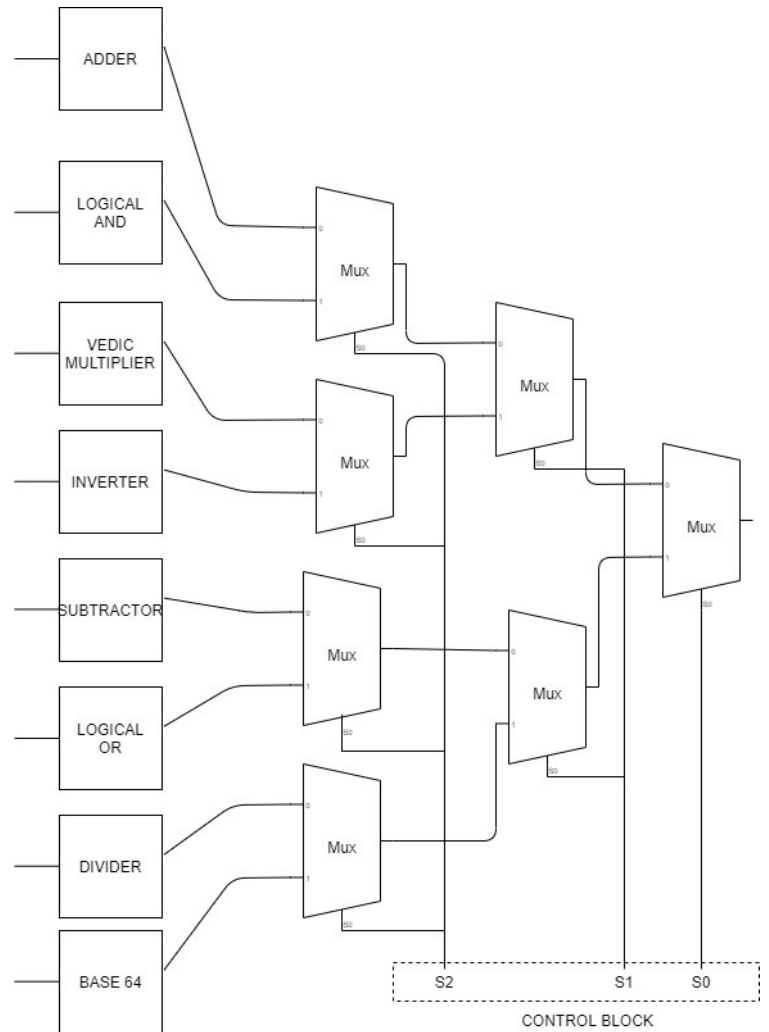
Figure 1. ALCU block diagram including